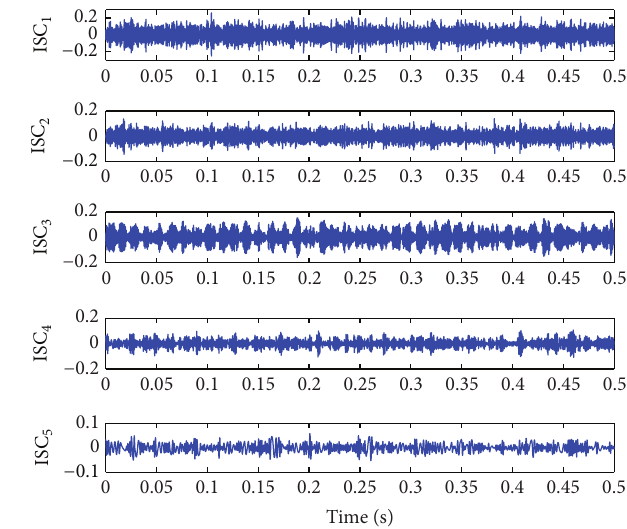
Figure 5: The first five-order components of